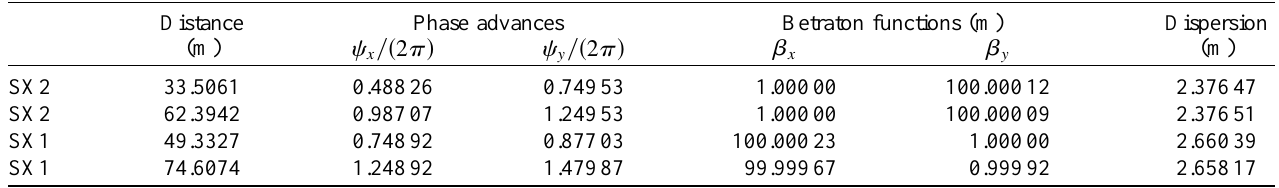
TABLE XII. Twiss properties of the IR correction